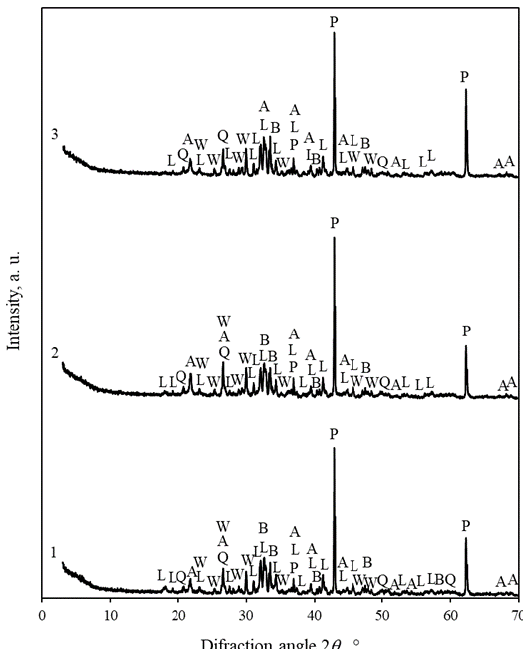
Figure 11. XRD patterns of akermanite synthesized for 1 h (1) and after 24 h of carbonization at 25 °C (2) and 45 °C (3). Indexes: A—akermanite, Q—quartz, W– wollastonite, L– larnite, B—bredigite, P—periclase.